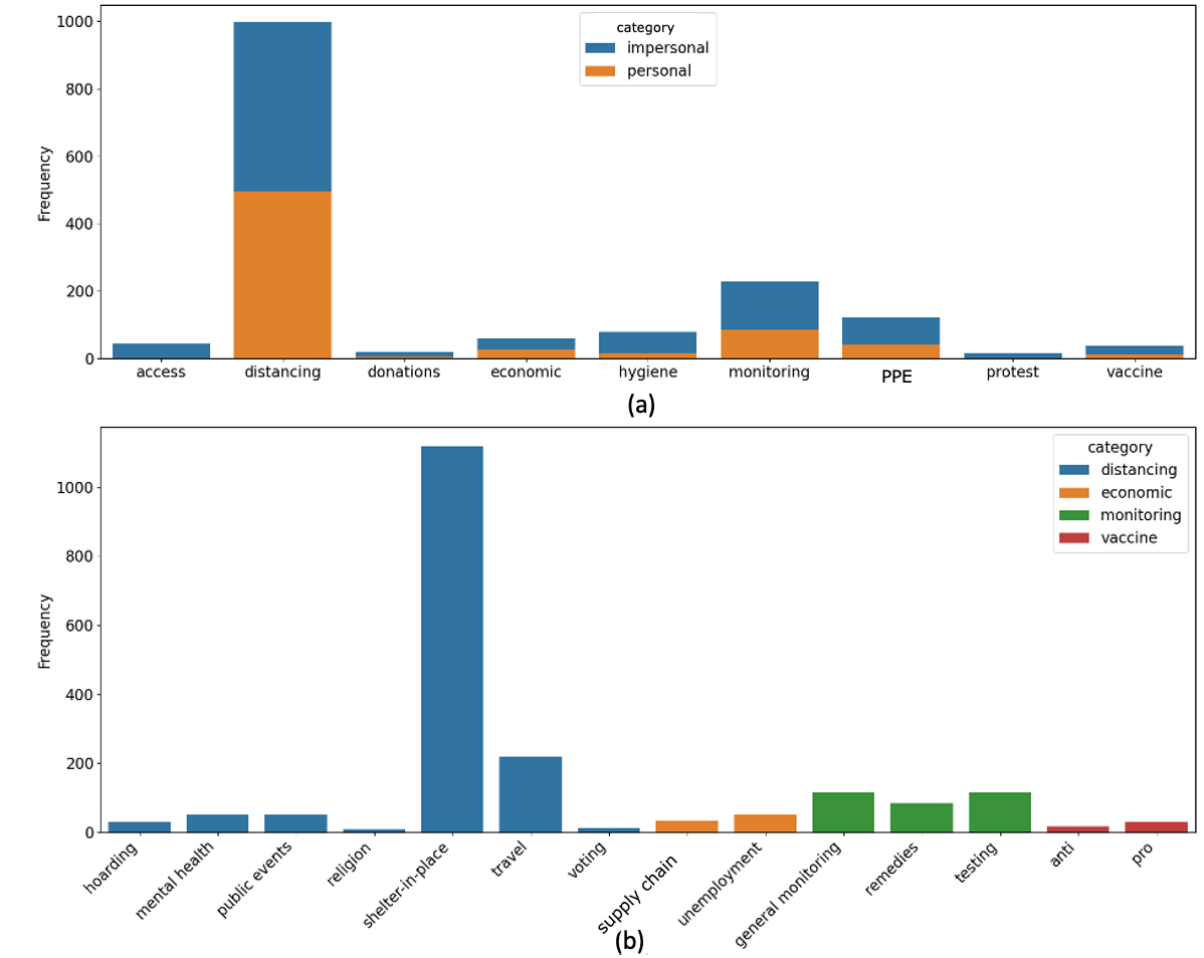
Figure 2. Category distribution. Tweets are broken down by frequency of personal and impersonal labels (a) and by subcategory grouped by category (b). Categories without subcategories are not shown in (b). Only categories with at least 80 labels, and subcategories with at least 50 labels, are shown. PPE: personal protective